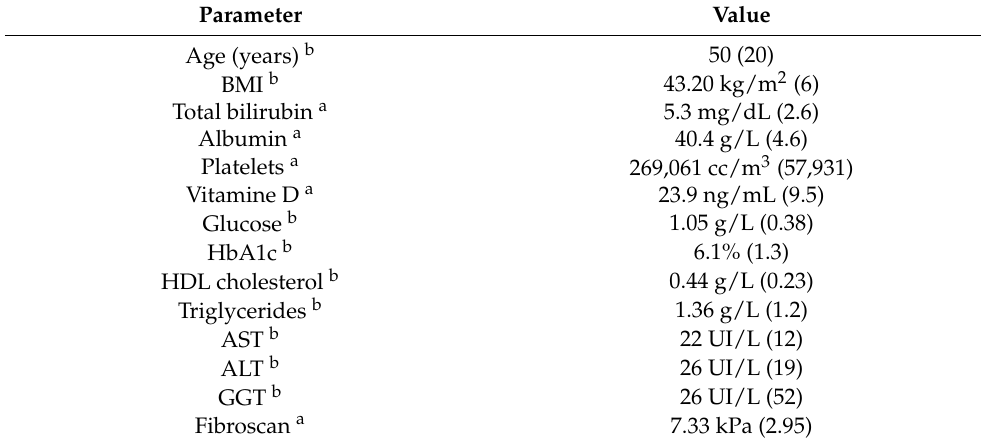
Table 1. Patient baseline